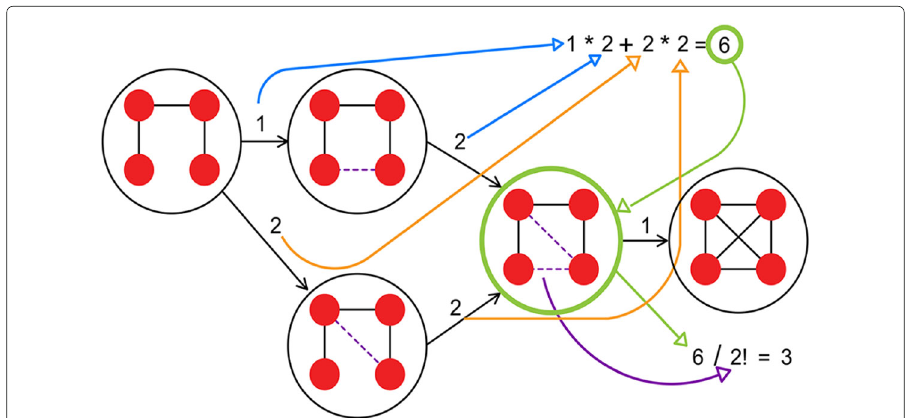
Fig. 7 TIAS T (cid:4) of the 4-nodes path m with an example of computation of the number of non-redundant occurrences of the 4-nodes square with diagonal m (cid:4) (the subgraph surrounded by a green circle) generated from m . There are two paths P 1 and P 2 between m and m (cid:4) . P 1 has weight 2, equal to the product of the weights of its edges (1 and 2). Likewise, P 2 has weight 4, given by the product of the weights of its edges (2 and 2). The total number of occurrences of m (cid:4) generated from m is the sum of the weights of P 1 and P 2 , i.e. 6. The final number of non-redundant occurrences of m (cid:4) generated from m is 6/2!=3, where 2 is the level of m (cid:4) in T